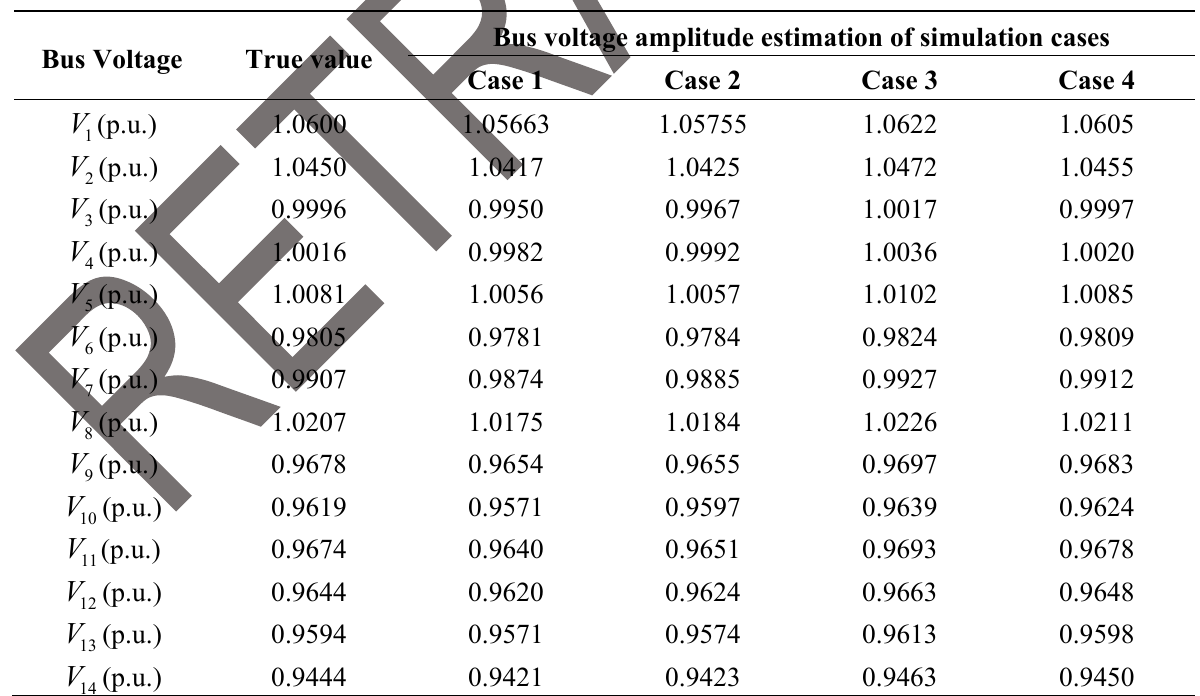
Table 2. Bus voltage estimation of the cases used in